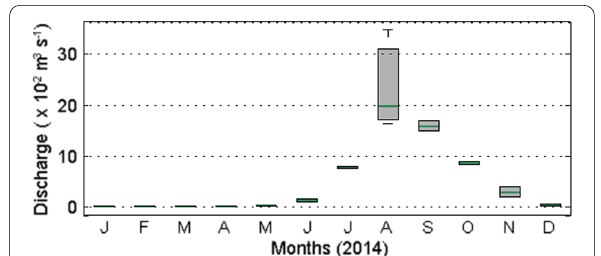
Fig. 2 Box plot for annual variation of river discharge measured fortnightly at non‑tidal Kamarkhali station upstream of the Pasur River Estuary in 2014. The two end whiskers indicate the minimum and maximum, and the box is defined by the lower and upper quartiles, with the center line (green) for the median